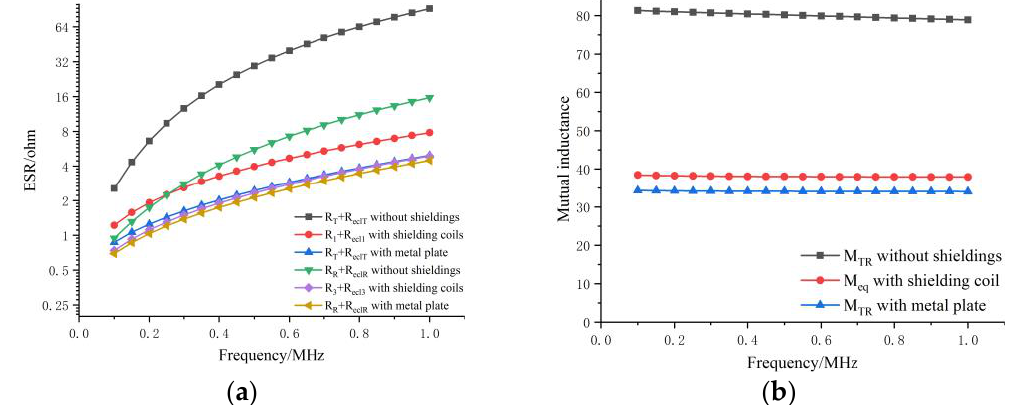
Figure 11. The relation between equivalent series resistance (ESR) of coils, the equivalent mutual inductance between coils and the work frequency. ( a ) ESR of coils change with frequency for three structure WPT system. ( b ) The mutual inductances change with frequency for three structure WPT system.